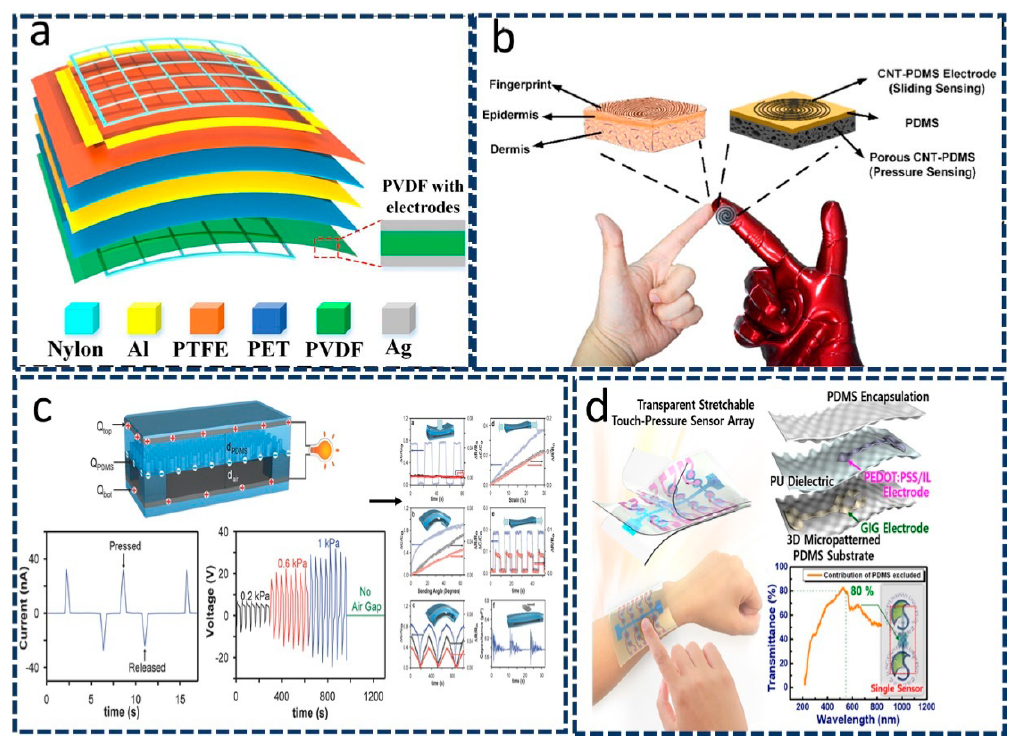
Figure 3. Two − principle integrated wearable sensors. ( a ) An integrated triboelectric–piezoelectric self-powered sensor. Reproduced with permission from Elsevier (2021) [40]. ( b ) A comparison diagram of fingertip and e-skin. Reproduced with permission from Elsevier (2017) [41]. ( c ) The e-skin can not only sense strain, pressure, and bending, but also detect lateral strain. Reproduced with permission from Wiley (2014) [45]. ( d ) Through the capacitive and piezoresistive effects of the transparent flexible sensor, touch and pressure can be detected. Reproduced with permission from Springer Nature (2019) [46].